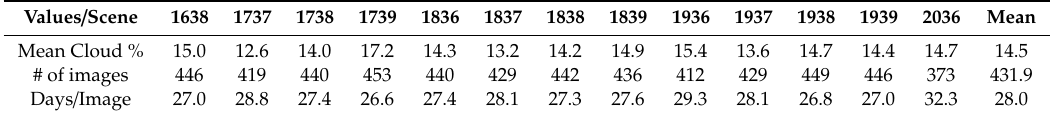
Table 1. Dense Landsat time-series data summary by scenes. Four-digit numbers at the header represent the WRS-2 row / path combination of the scene. The first two digits represent the path number and the following two digits represent the row number (e.g., “1638” refers to path 16 and row 38). The “number (#) of images” row represents the total number of available images for each scene captured between April 1984 and December 2016. The “Days / Image” row represents the average length of time from the acquisition of an image to the acquisition of the next image in Google Earth Engine